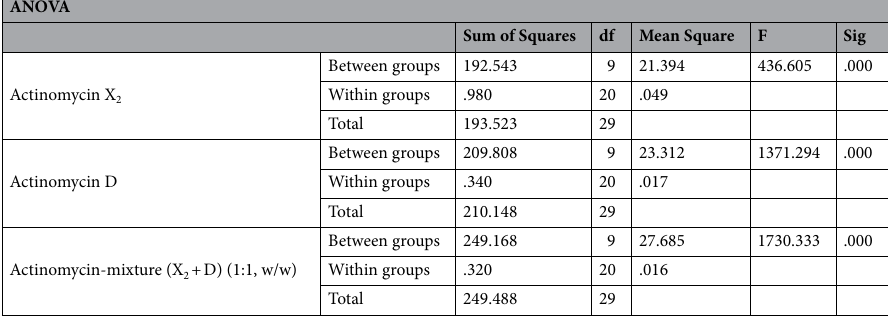
Robust tests of equality of means